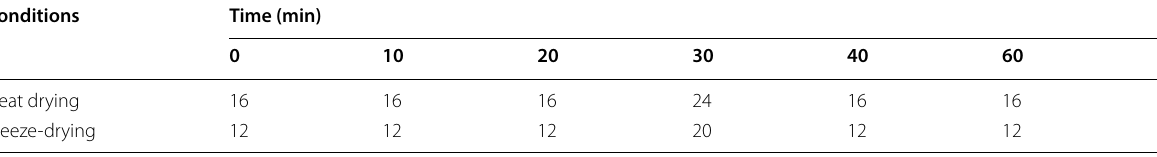
Table 1 The number of pots on WF fabrication